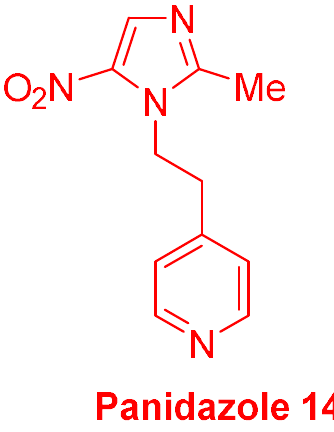
Figure 26. Chemical structure of Panidazole 140 .